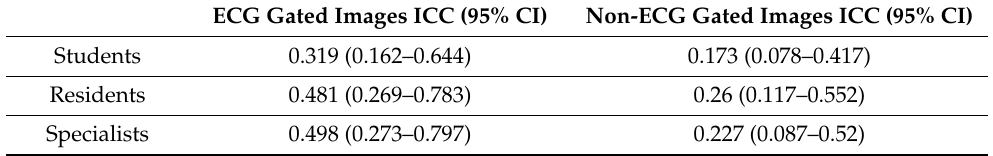
Table 2. Inter-rater reliability for the three groups of reporters, detailed by the usage of gating for image